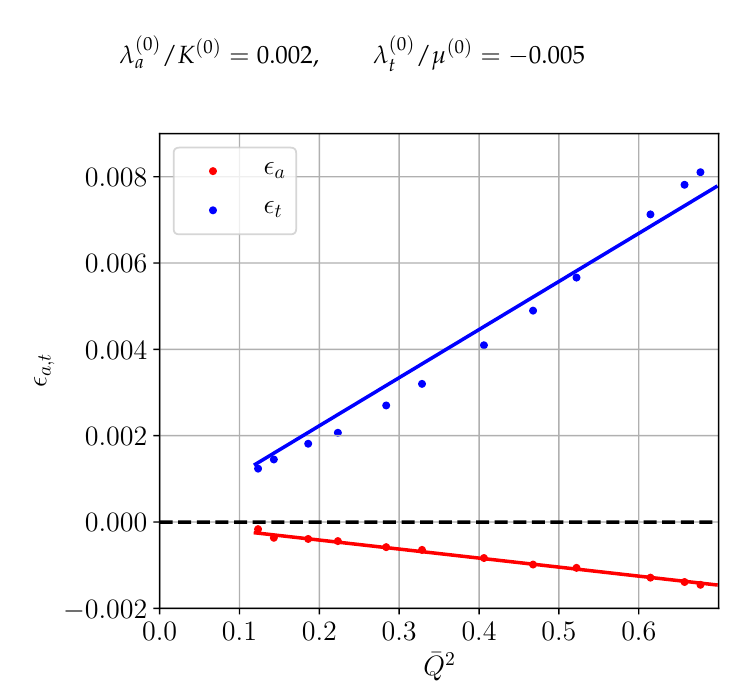
Figure 3. Fits of (cid:101) a ( T ) and (cid:101) t ( T ) against Q 2 ( T ) according to Equations